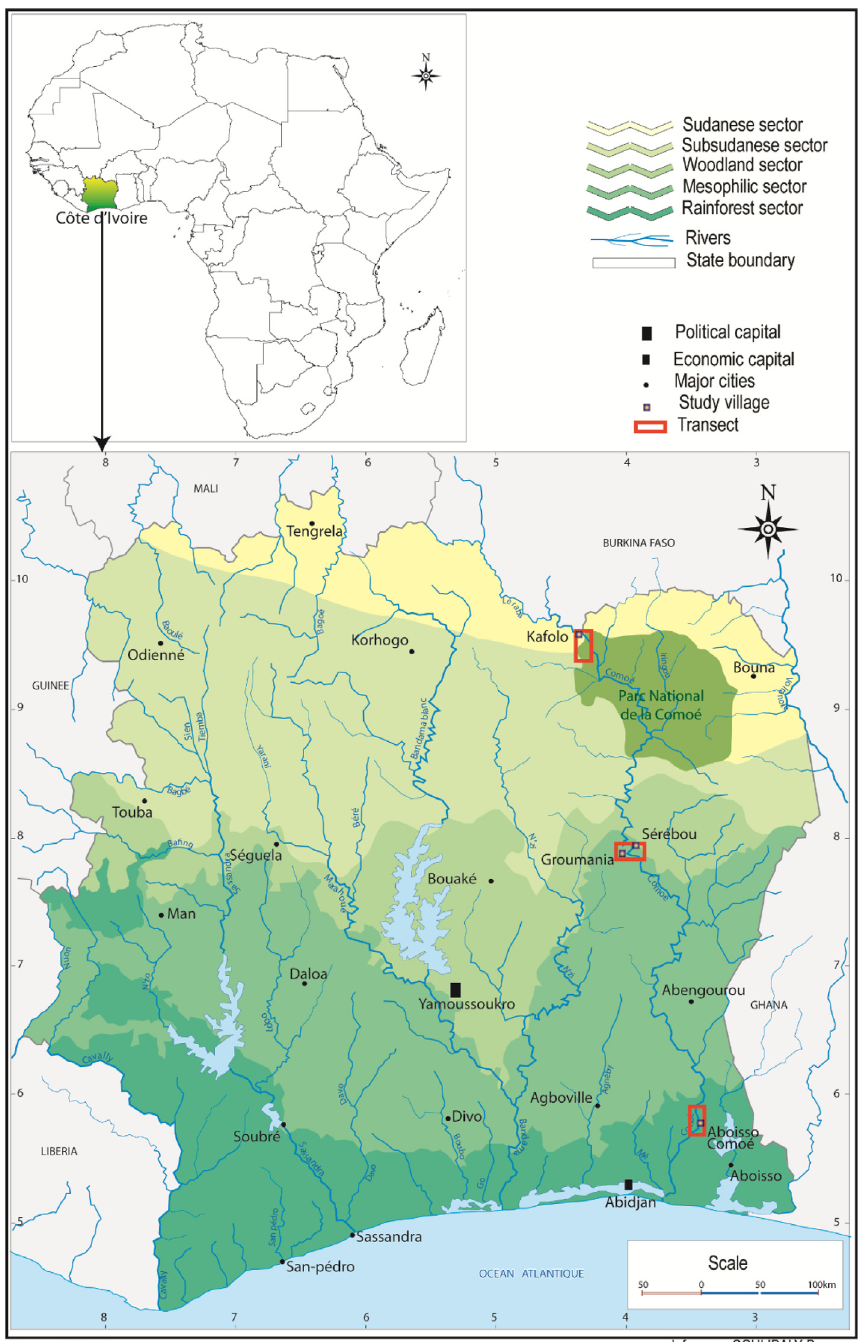
Figure 1. Location of study sites along the Comoé River in Côte